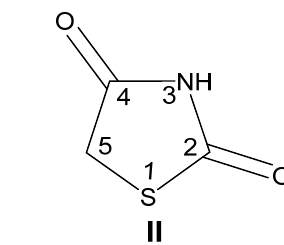
Figure 1. ( I ) General structure of 2 ‐ (4 ‐ oxo ‐ 2 ‐ thioxothiazolidin ‐ 3 ‐ yl)acetic acid derivatives, PMT1 inhibitors; ( II ) Structure of thiazolidine ‐ 2,4 ‐ dione (TZD).